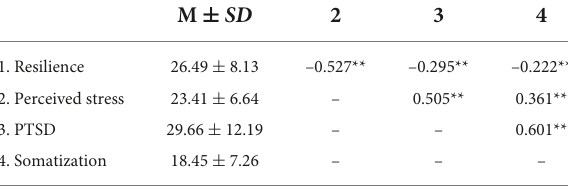
TABLE 4 Correlation between the study variables ( n =